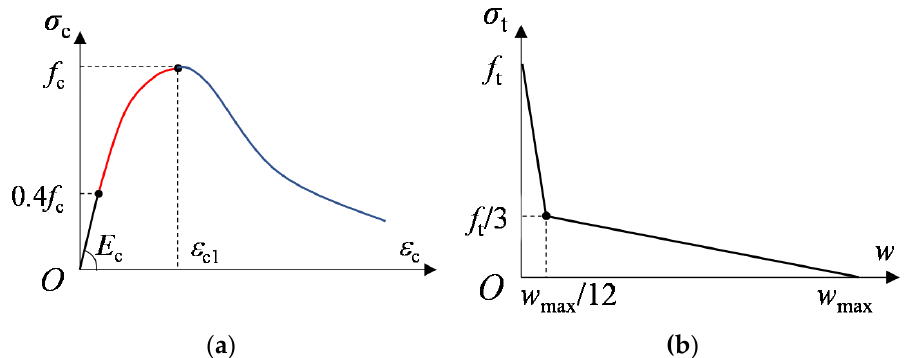
Figure 8. Concrete constitutive model: ( a ) Uniaxial compression; ( b ) Uniaxial tension. For concrete in tension, the tensile stress is assumed to be linearly with respect to strain up to the concrete tensile strength. Beyond this point, concrete crack initiates. Then, a bi-linear tensile stress–crack width diagram is assumed, as shown in Figure 8. Here, the maximum crack width ( w max ) was taken as 0.18 mm [21]. Besides uniaxial compressive and tensile constitutive model, there are several key pa- rameters in CDP model determining the yield function, flow rule, and hardening rule [17]. By reference to existing research on numerical modeling of headed stud shear connec- tors [18,22], values of these concrete material parameters used in this study are listed in Table 3. Table 3. The employed material parameters for the finite element models. Poisson’s Dilation Eccentricity Biaxial-to-Uniaxial Shape Viscosity Ratio Angle Factor Strength Ratio Factor Parameter